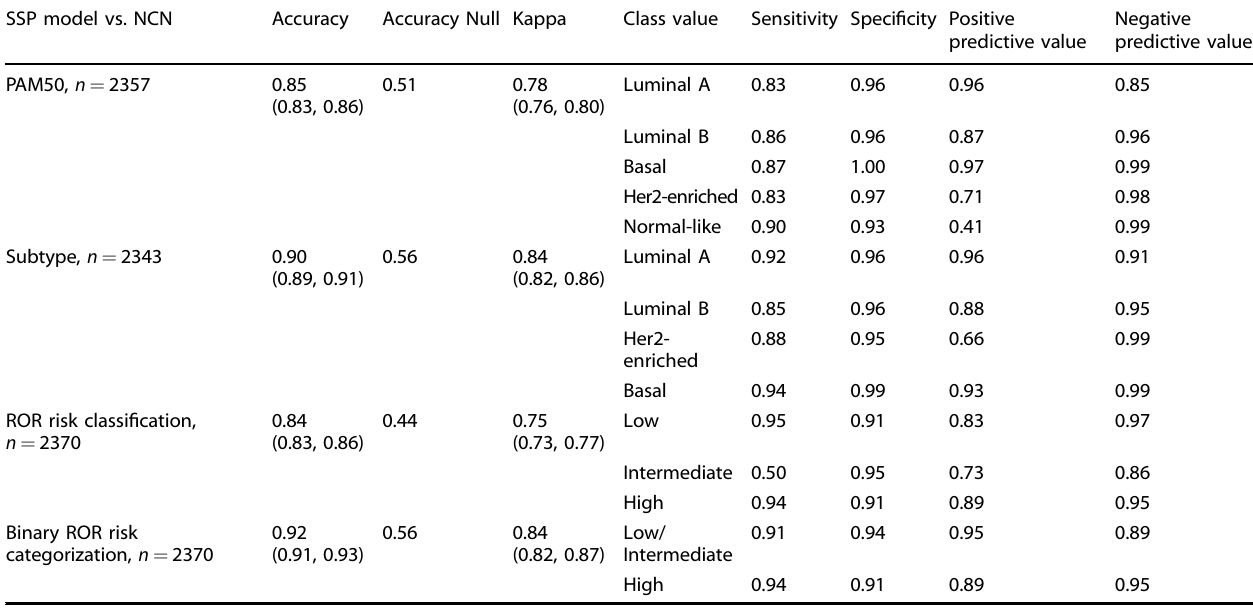
Table 2. SSP prediction performance for subtypes and ROR categories validated against NCN classi fi cation in the independent population-based test set of early breast